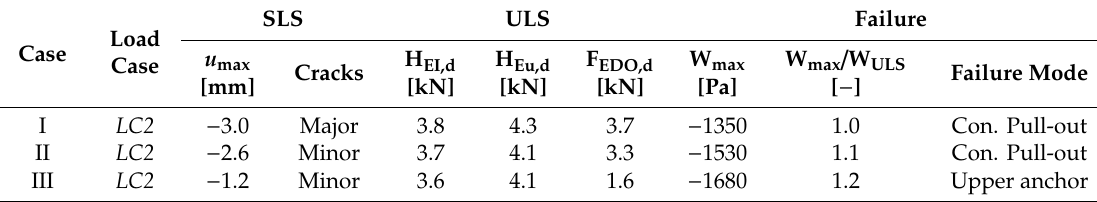
Table 6. Summary of results for the di ff erent connector configurations subjected to